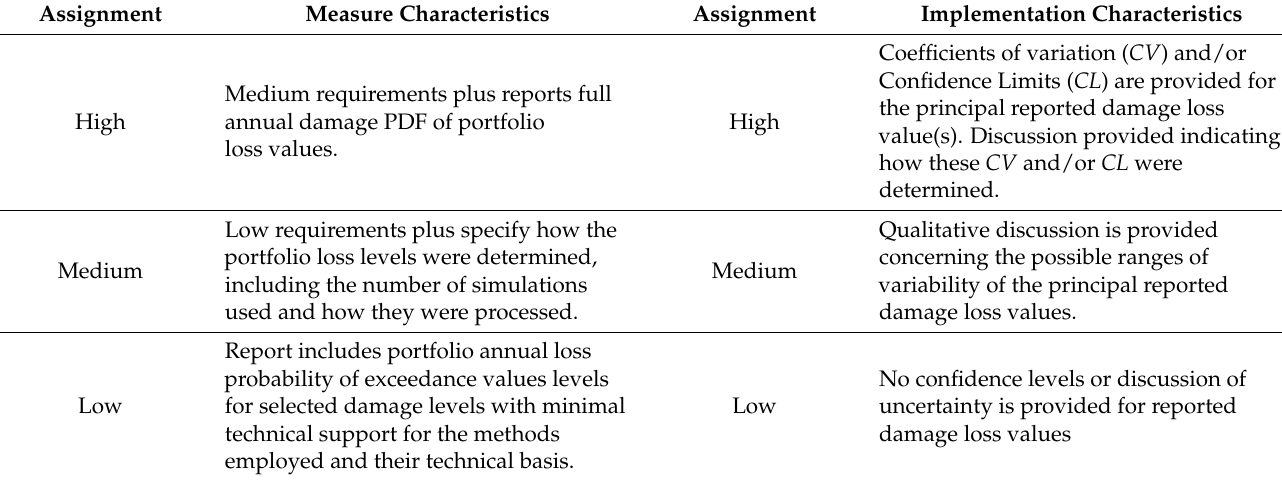
Table 13. Definitions of Measure Characteristics and Implementation Characteristics for the components of the Loss Simulations evaluation. These are assumed to be given as a probability of the damage level confidence bound for median probability for a given dollar loss. Not all loss values will have the same confidence span. The resulting uncertainty values determined from Table 1 will be labeled C . Note that the actual computed CV is not considered in this evaluation, it is considered in Section